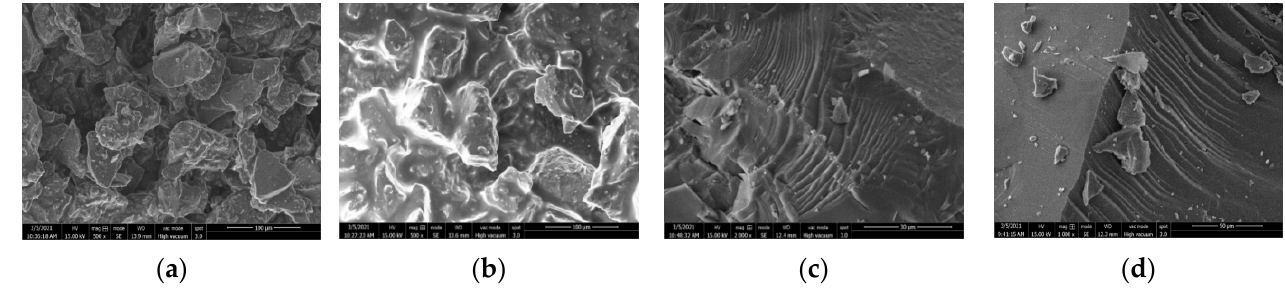
Figure 15. Typical microscopic morphology of vertical fracture fragments. ( a ) Transgranular pull flowers; ( b ) Flowering along crystal; ( c ) Step pattern; ( d ) Stepped flowers.